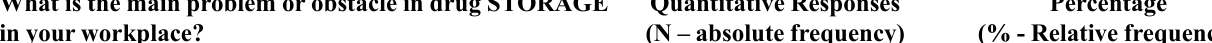
TABLE III - Main problems of drug storage, according to pharmacists of Maranhão State (n = 78) What is the main problem or obstacle in drug STORAGE in your